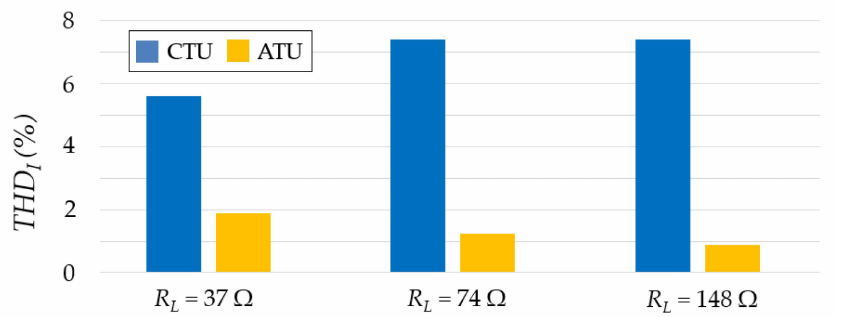
Figure 16. Comparison of input current THD at different loads.